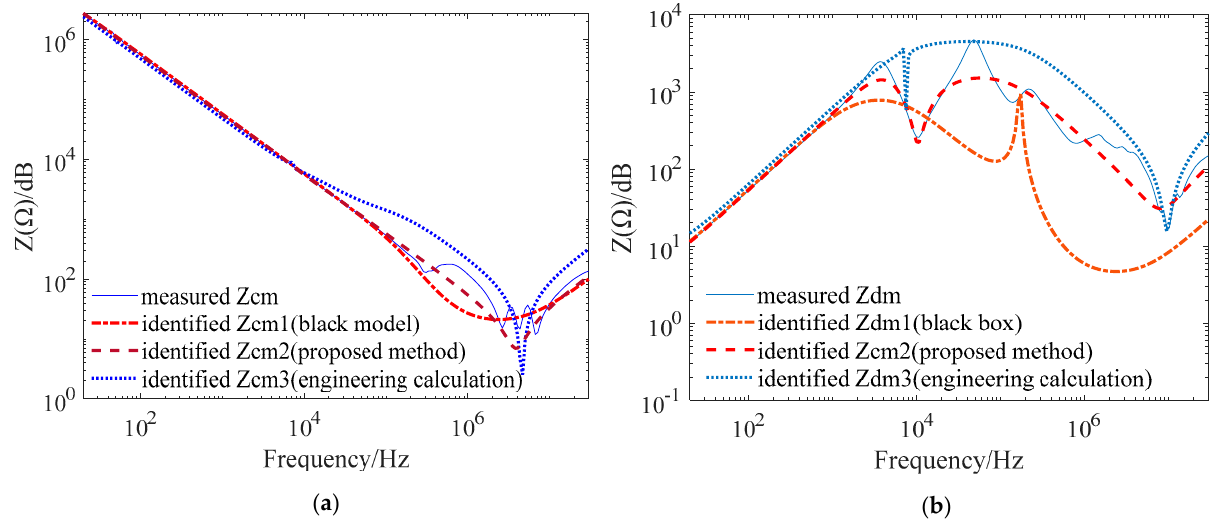
Figure 8. Comparison diagram of impedance characteristics: ( a ) comparison of common mode impedance characteristic curves; ( b ) comparison of differential mode impedance characteristic curves.